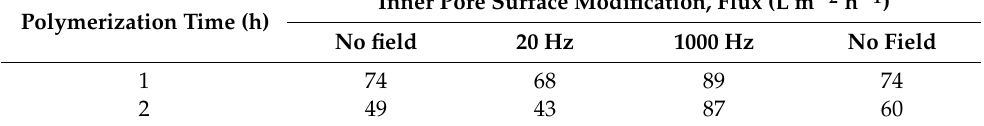
Table 5. Variation of BSA flux for inner membrane pore surface modification. Results are shown in the absence and presence of a 20 and 1000 Hz oscillating magnetic field. Average results are provided with a range of ± 8 L m − 2 h − 1 . The feed pressure was 10.3